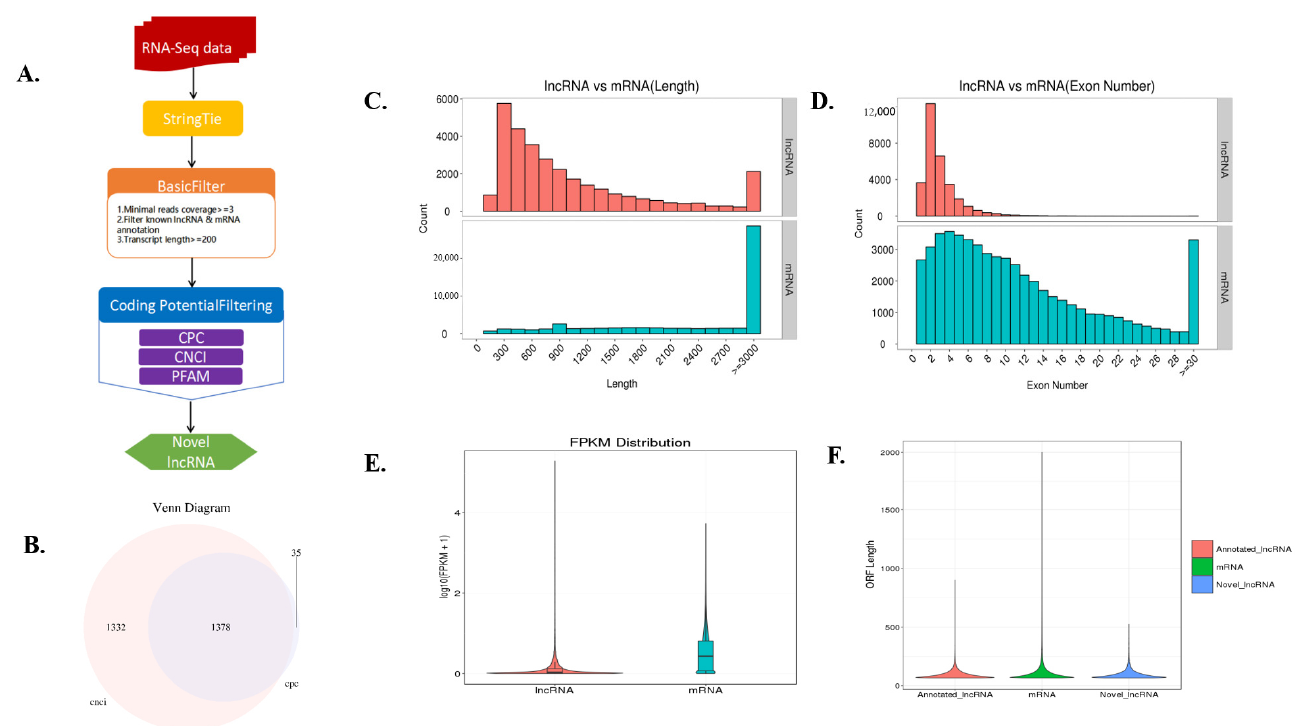
Figure 1. Identification of long noncoding RNAs (lncRNAs) and their comparison with mRNAs at the genomic structure and expression levels. ( A ) Workflow for lncRNA identification. ( B ) Candidate lncRNAs were identified by using two applications: CNCI (coding-noncoding-index) and CPC (coding potential calculator), which detect and remove putative protein-coding transcripts. ( C ) Distribution of lengths of lncRNAs and mRNAs. ( D ) Distribution of the number of exons of lncRNAs and mRNAs. ( E ) Expression levels of lncRNAs and mRNAs, calculated as log10(FPKM + 1). FRKM: Fragments per kilobase of exon per million fragments mapped. ( F ) The ORF sequence is converted to the length of the protein sequence .